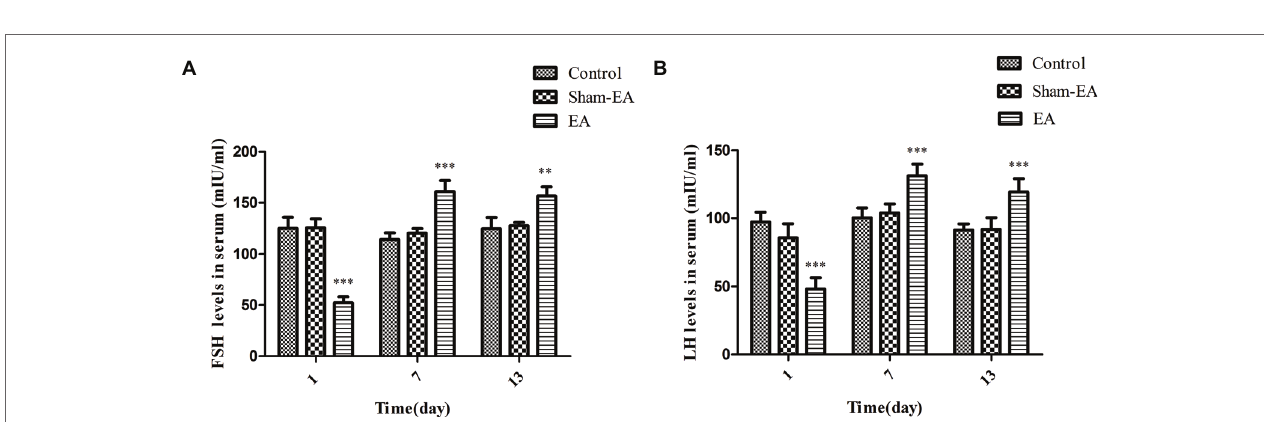
FIGURE 3 | Serum FSH and LH levels at day 1, 7, and 13 after EA treatment. (A) Serum FSH levels. (B) Serum LH levels. Data are presented as means ± SD, * indicates the changes of the hormone levels are different between EA-treated rats and the Control or Sham-EA rats, ** p < 0.01, *** p <